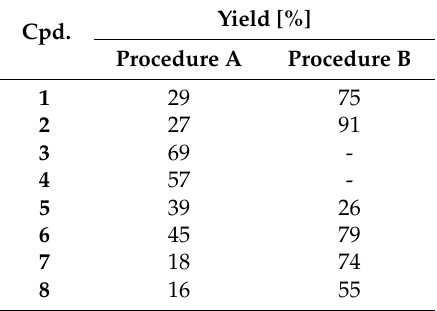
Table 1. Summary of achieved yields * of benzyl derivatives 1 – 8 by procedure A and B. Yield [%] Cpd.